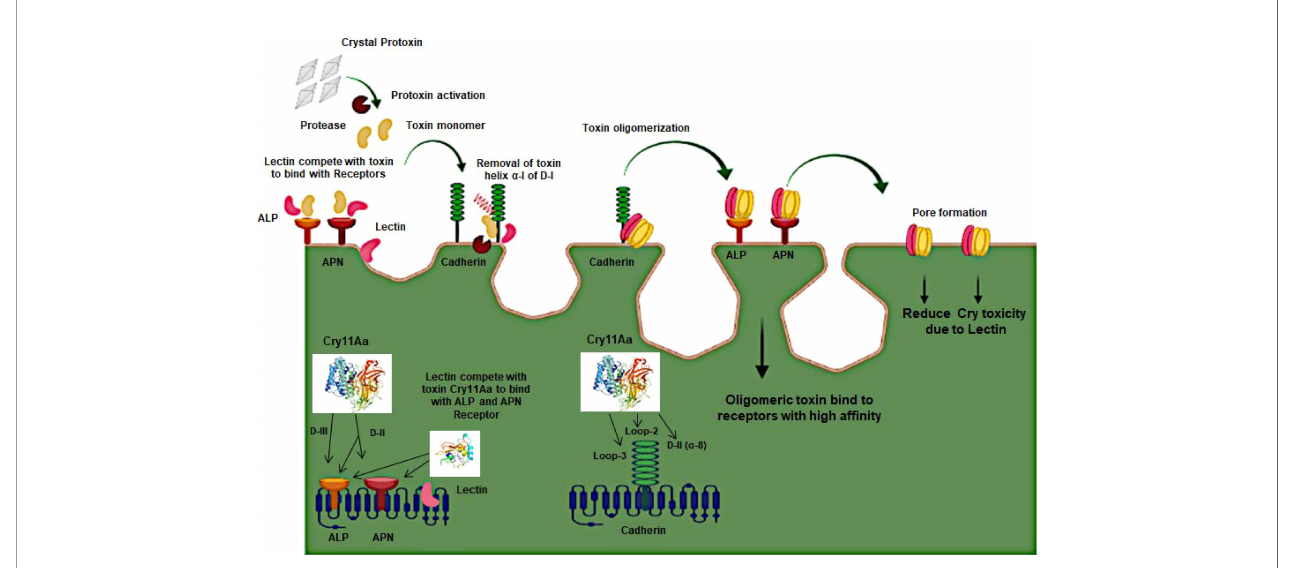
FIGURE 3 | Schematic presentation of the 3D-Cry toxin mechanism with Receptors and Lectin in